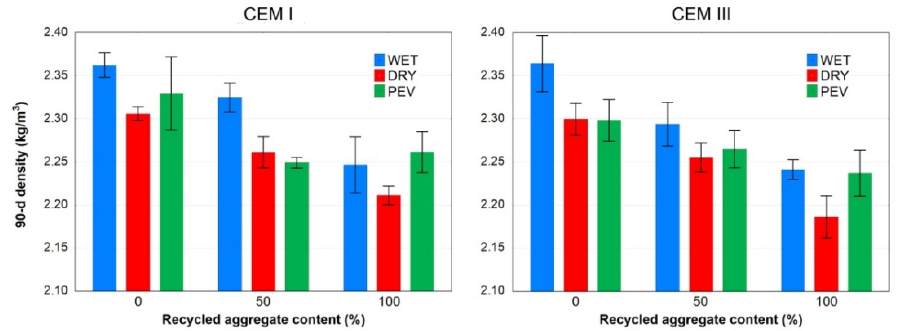
Figure 3. Average density of 90-day concrete.